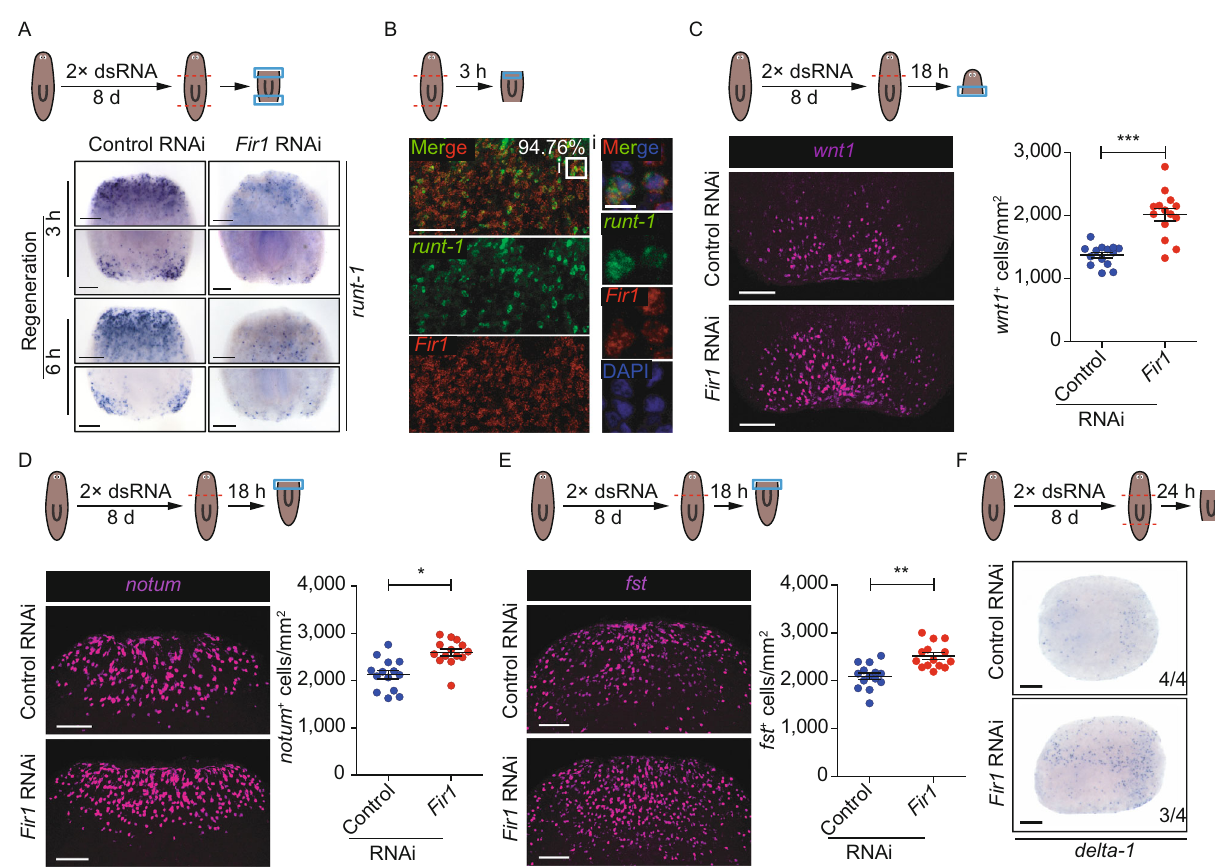
Figure 6. Fir1 is required for neoblast wound recognition during regeneration initiation. (A) Fir1 (RNAi) trunk pieces displayed reduced runt-1 + cells at the wound sites 3 h and 6 h after amputation ( n = 10/10). (B) Representative confocal projections through trunk pieces fi xed 3 h post-amputation, labelled with runt-1 (green), Fir1 (red) and DAPI (blue). The images shown indicate the region near the anterior wound site. Box indicates zoomed-in region. The number indicates the percentage of runt-1 + cells co-expressing Fir1 ( n = 210 cells). Ventral view; scale bar, upper panel: 50 μ m; lower panel: 10 μ m. (C) Fir1 (RNAi) head pieces displayed increased wnt1 + cells at the wound sites 18 h after amputation ( P < 0.0001, two-tailed t test). (D) Fir1 (RNAi) animals displayed increased notum + cells at the wound sites 18 h following head amputation ( P < 0.05, two-tailed t test). (E) Fir1 (RNAi) animals displayed increased fst + cells at the wound sites 18 h following head amputation ( P < 0.001, two-tailed t test). (F) Fir1 (RNAi) animals increased wound-induced expression of delta-1 24 h after amputation ( n = 3/4). Scale bars, (A, C, D and E) 100 μ m, (B and F) 200 μ